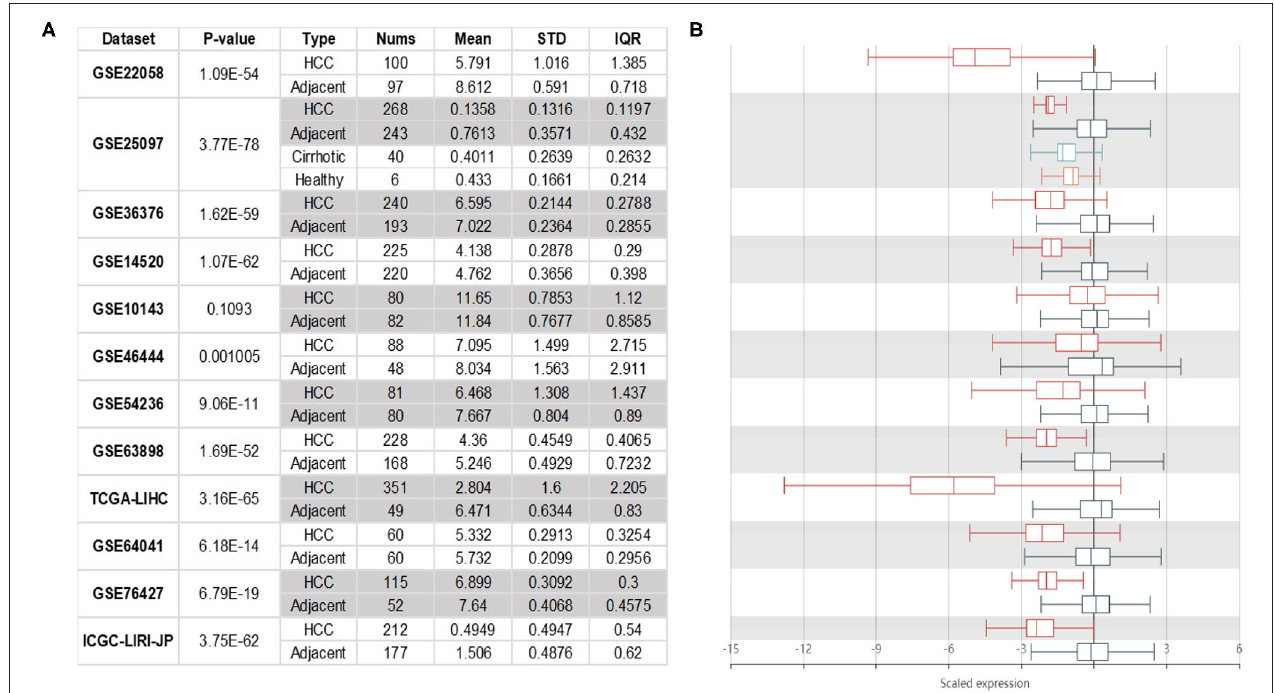
FIGURE 1 | NTF3 mRNA expression in HCC. NTF3 mRNA expression in liver cancer tissues is significantly lower than normal tissues. (A) The table shows the specific expression of NTF3 mRNA in liver cancer tissues and normal tissues in the HCCDBs database. (B) The boxplot shows the comparison of the expression of NTF3 mRNA in liver cancer tissues and normal tissues in the HCCDBs database.